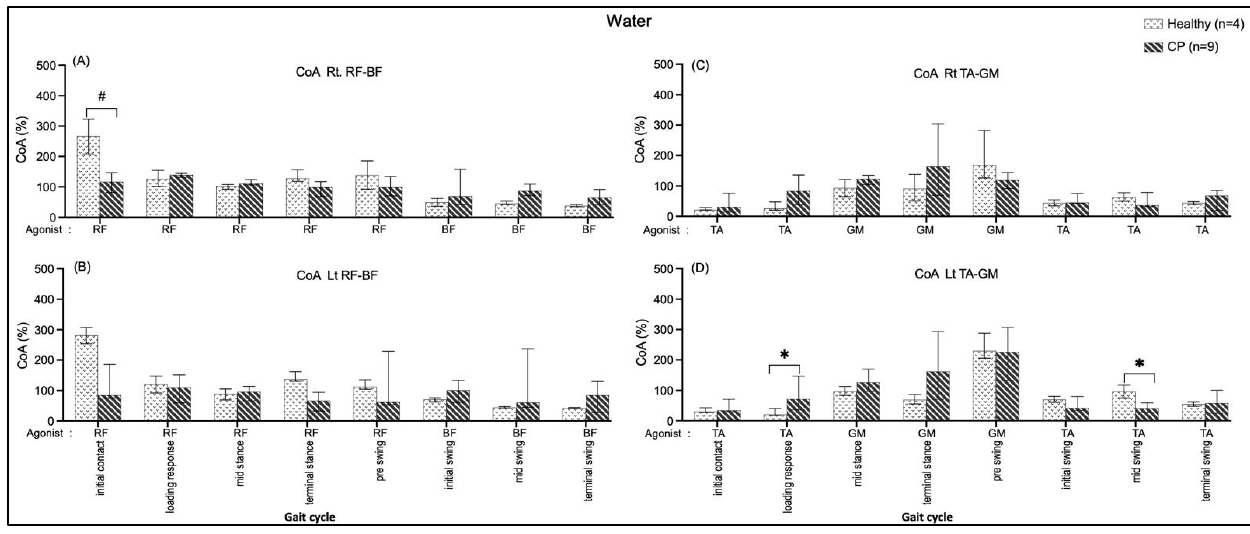
differences between walking on land and in water at p < 0.05 and p < 0.01, respectively.